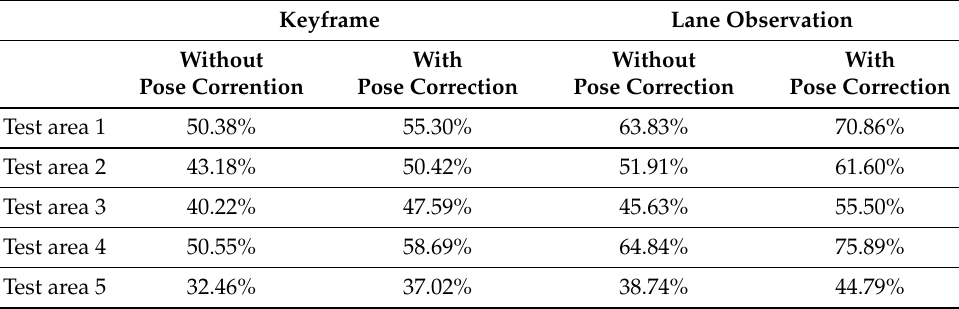
Table 2. The ratio of utilized crowdsourced data after the validation